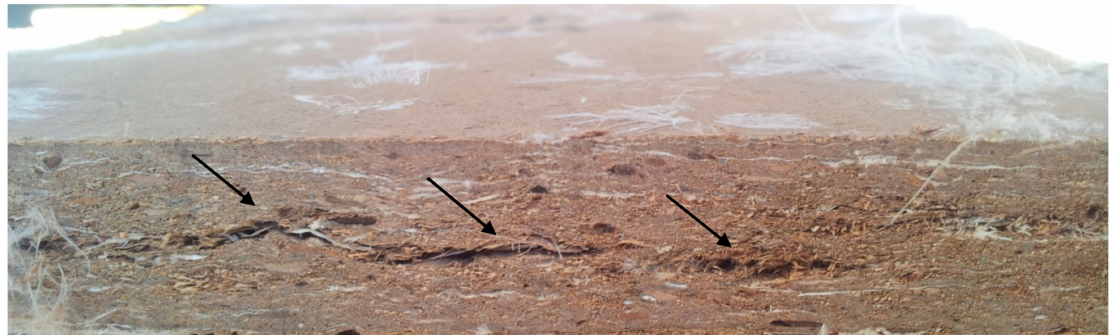
Figure 3. Cracks (blows) ( ↓ ) in the core layer of MDF-feather boards